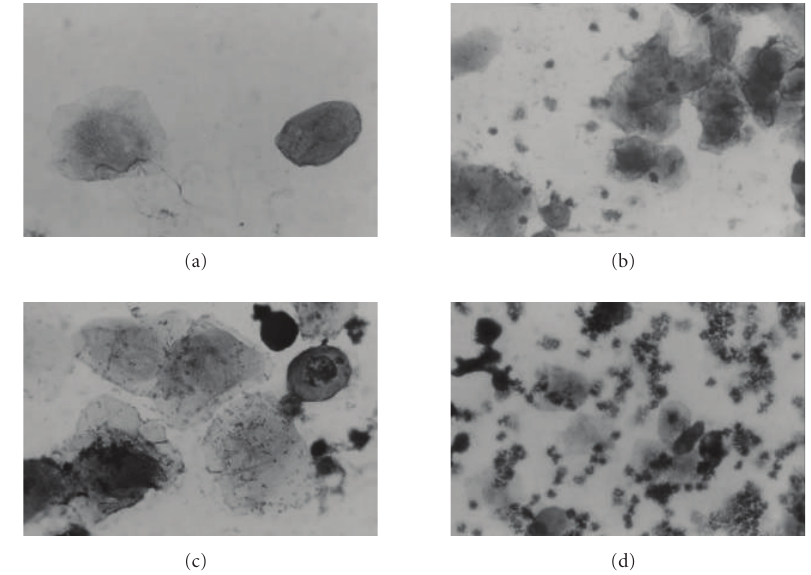
Figure 3: Vaginal smears stained with Giemsa of mice that were inoculated with lactobacilli and/or staphylococci. (a) Lactobacilli treated group; (b), (c) lactobacilli + pathogen treated group; (d) pathogen treated group. Magnification is 40X.